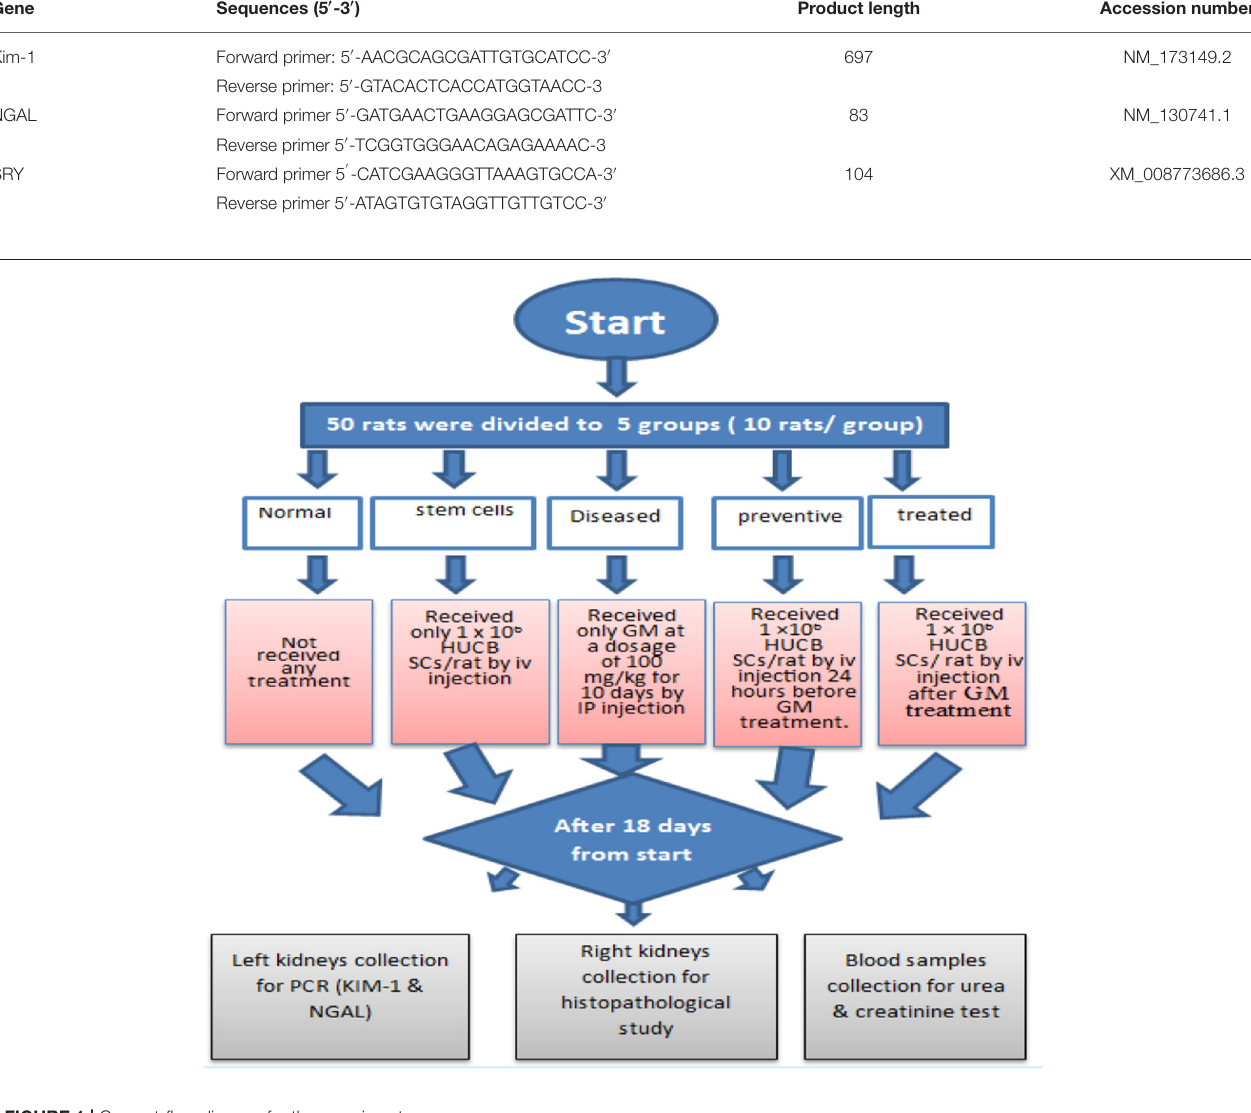
FIGURE 1 | Consort-flow diagram for the